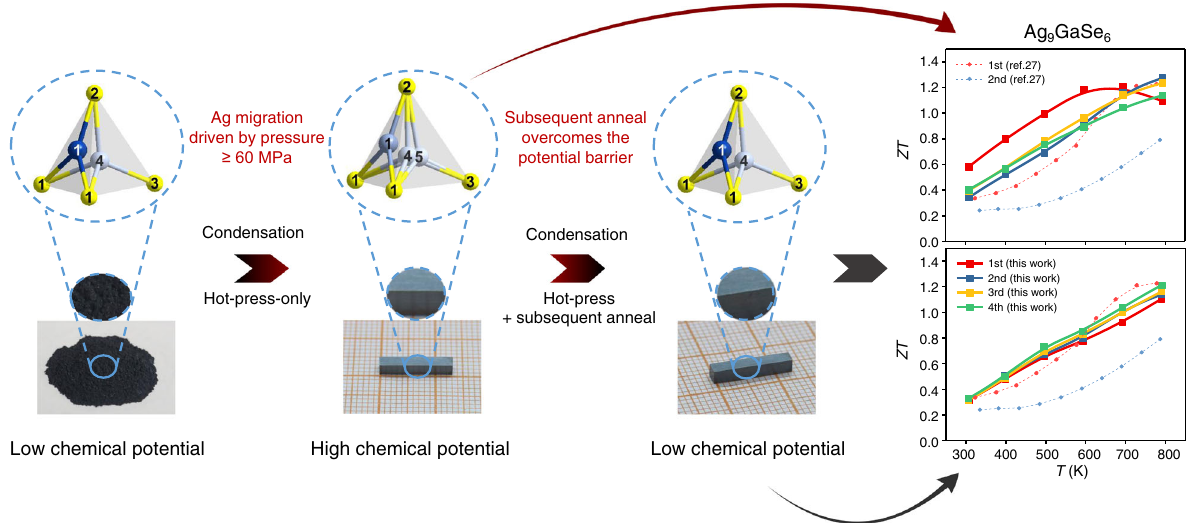
Fig. 1 Schematic illustration of the hot-pressed-annealed condensation process of the Ag 9 GaSe 6 -based n -type thermoelectric materials that exhibit unprecedented stability and reproducibility, which suggests that they have a great application potential as excellent n -type TE materials. Standard hot-pressing promotes Ag atoms to migrate to the tetrahedron center, a high chemical potential site with larger coordination number. Ag atoms located at these metastable sites tend to be easily reduced, leading to the well-known TE property irreproducibility. We discovered that a simple hot-pressed- annealed treatment helps metastable Ag atoms to overcome the potential barrier and migrate back to the original low-chemical-potential sites, and consequently show an unprecedented TE property